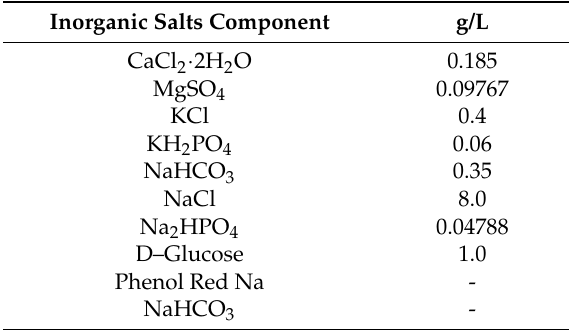
Table 6. Chemical composition of Hank’s